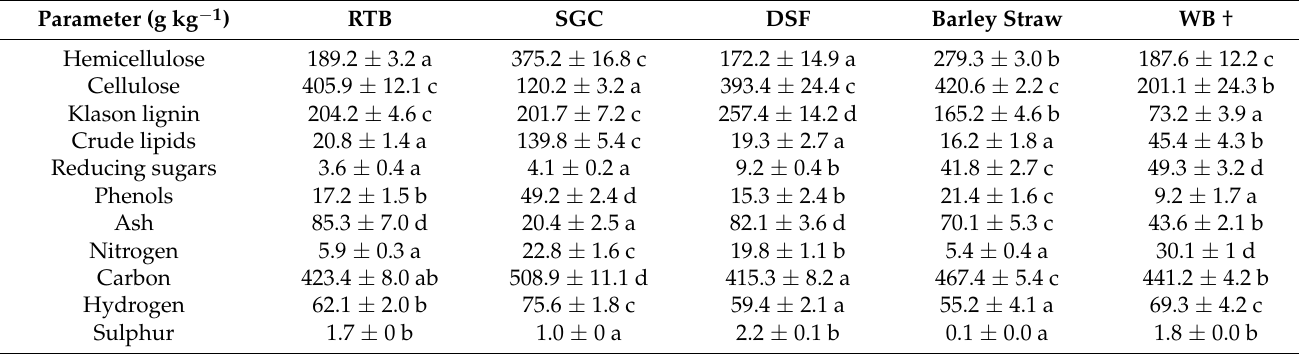
Table 1. Chemical composition of residual thistle biomass (RTB), spent coffee grounds (SCG), digestate solid fraction (DSF), barley straw and wheat bran (WB). The data, expressed as g kg − 1 of the dry weight, are the mean ± standard deviation of 3 determinations. Multiple pair-wise comparisons were made between the row means using the Tukey test; identical letters denote that row means were not significantly different ( p >